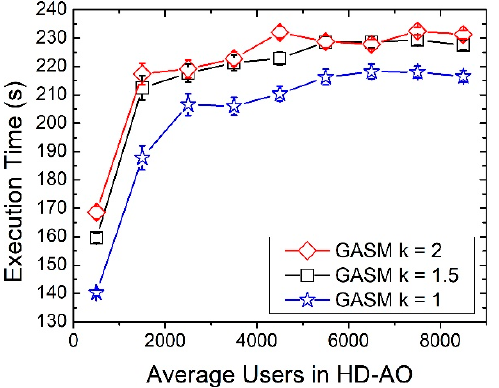
Figure 5. Execution times for GASM with k = 1, k = 1.5 and k = 2 .